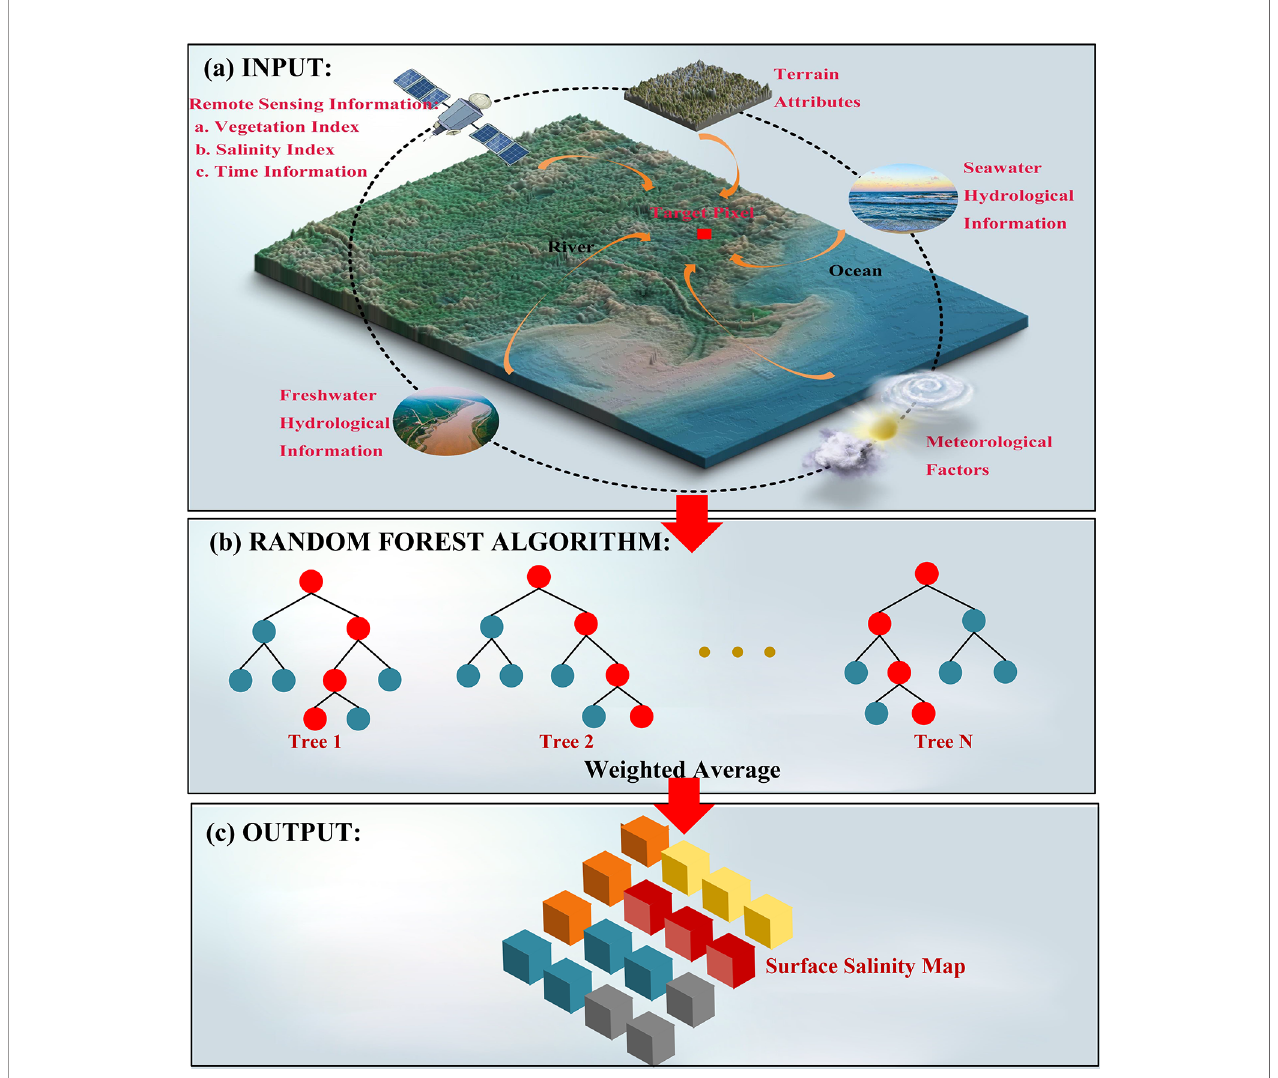
FIGURE 1 | Structure and speci fi c schematics of the random forest model based on hydrological connectivity metric. (A) The model bene fi ted from rich information of multi-resource data (including the remote-sensed spectral data, terrain attributes, meteorological data, temporal information, and hydrological connectivity metric). (B) The constructed random forest model integrated output results of all decision trees based on weighted average mechanism. (C) The model obtained the best estimation of surface soil salinity of each